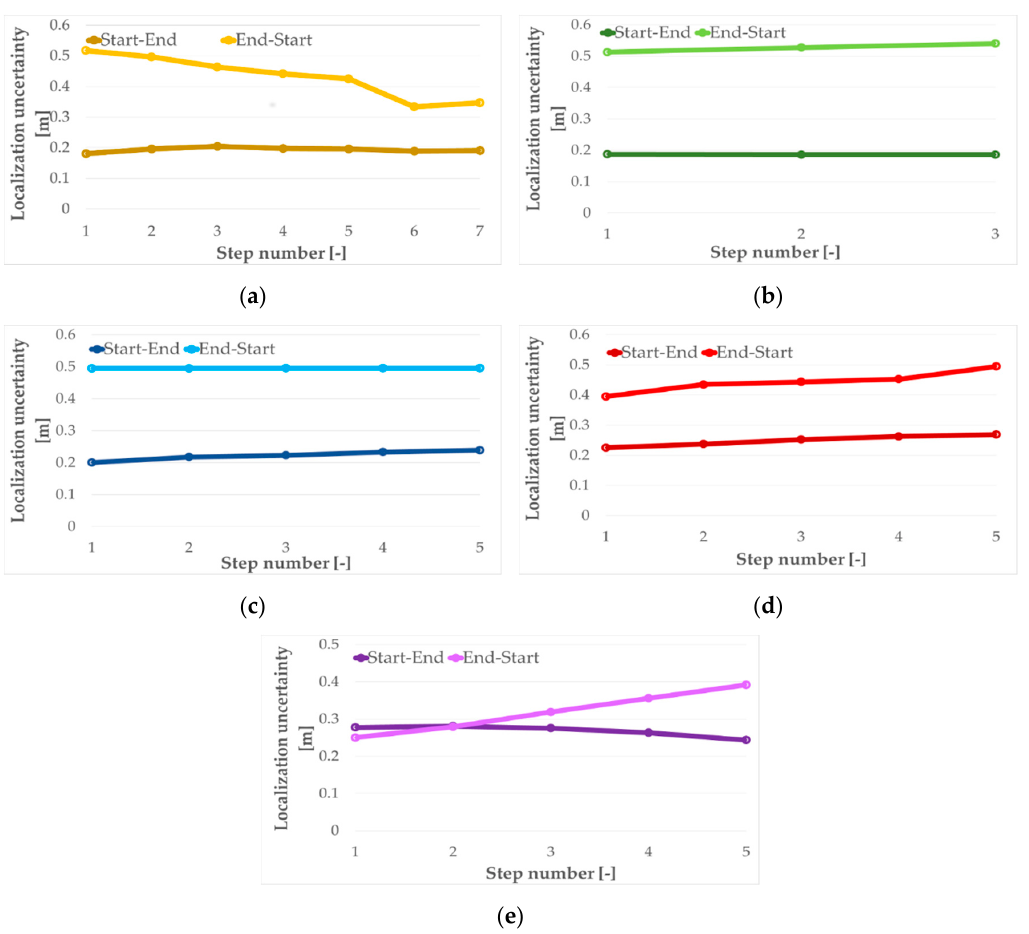
Figure 10. Localization uncertainty for each step for the two directions of the test path sections: ( a ) for I ; ( b ) for II ; ( c ) for III ; ( d ) for IV ; ( e ) for V.